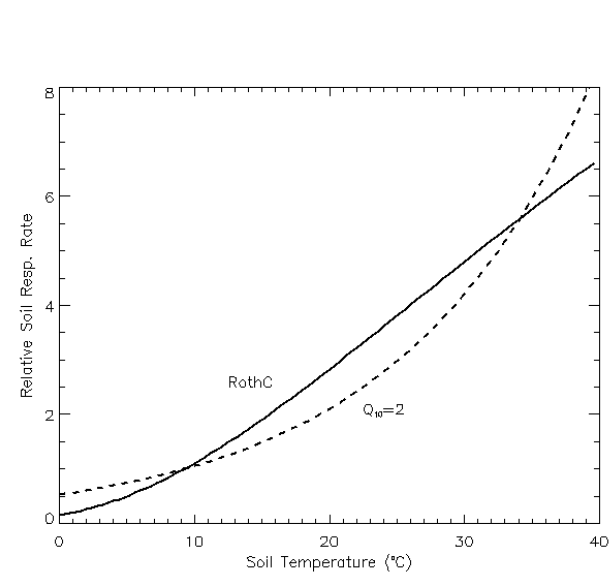
Fig. 2. Comparison of alternative forms for the sensitivity of spe- cific soil respiration to soil temperature in JULES. The dashed line shows a Q 10 form with Q 10 = 2, the solid line shows the form from the RothC model (Jenkinson,